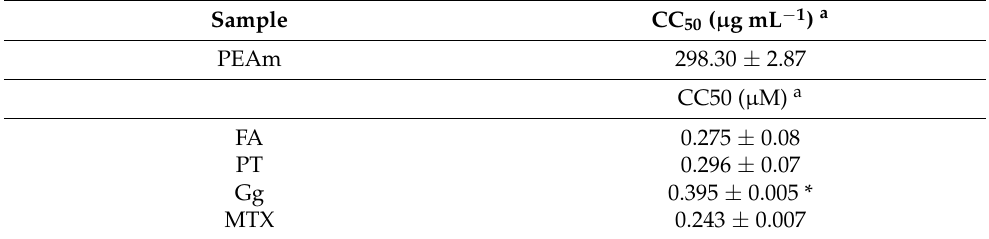
Table 4. Median cytotoxic concentration calculated after 24 h of exposure against U-937 cells from petroleum ether extract and its terpenoids geranylgeraniol (Gg), phytol (PT), and farnesyl acetate (FA) obtained and identified from A. macroprophyllata